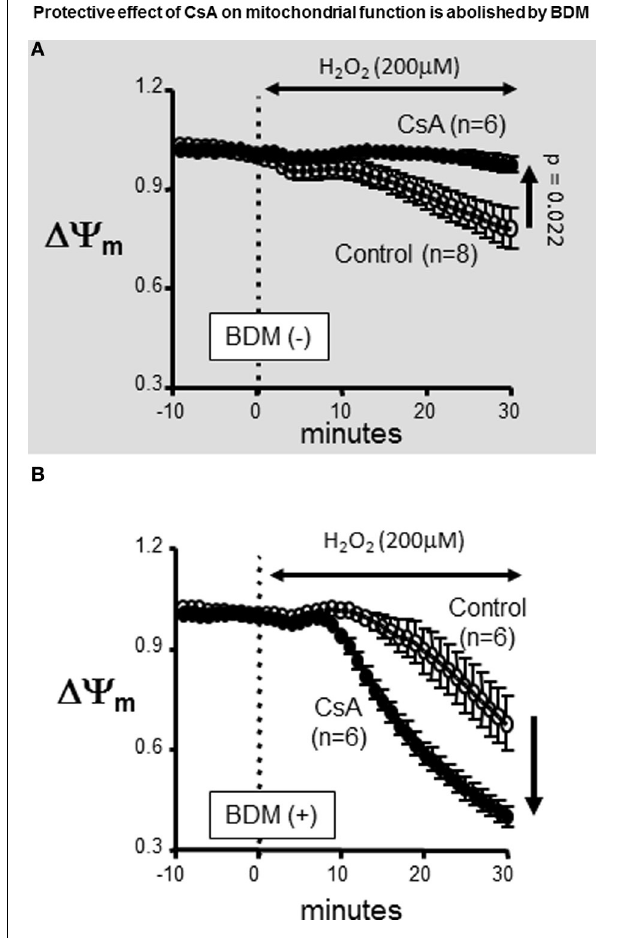
FIGURE 4 | Protective effect of CsA is abolished by PKC inhibition. (A) For reference, (cid:2)(cid:3) m response presented in Figure 1 indicating protection by CsA against OS-induced (cid:2)(cid:3) m depolarization. (B) Average (cid:2)(cid:3) m response to CsA treatment in the presence of the specific PKC inhibitor CHE. (C) Average (cid:2)(cid:3) m response in control and CHE treated hearts. CHE alone (i.e., without CsA) did not alter the response. CHE, Chelerythrine; PKC, Protein kinase